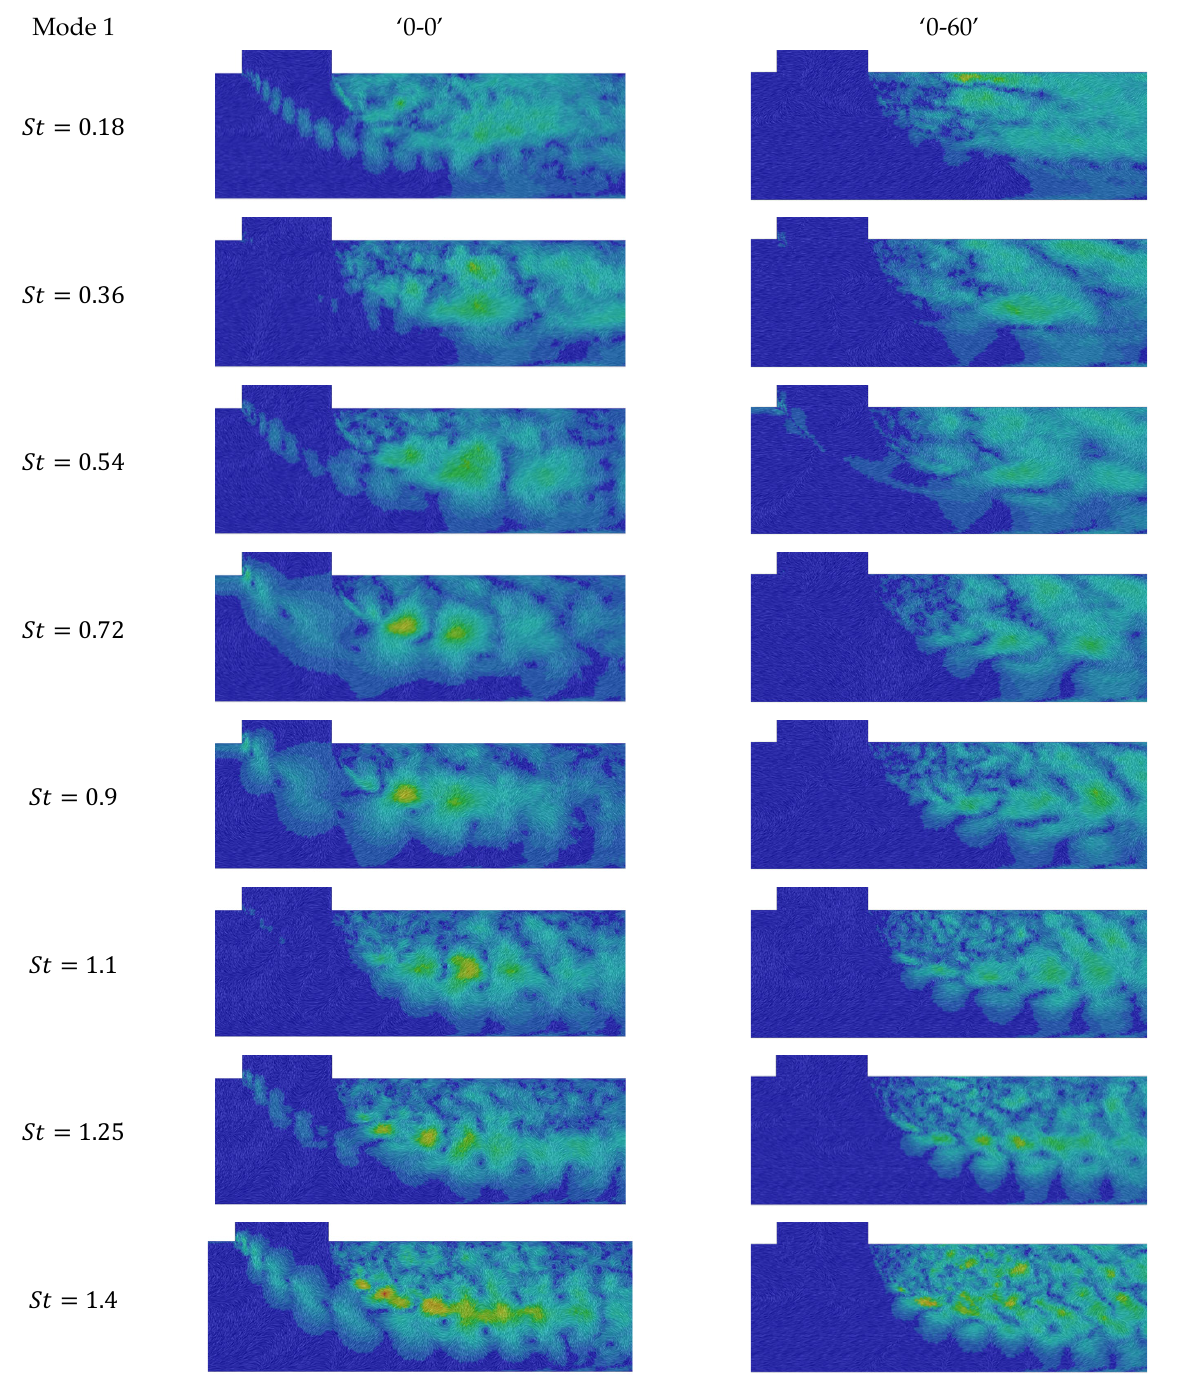
Figure 23. Contour plots of mode 1 of in-plane velocity vector coloured by mode magnitude for XZ plane.